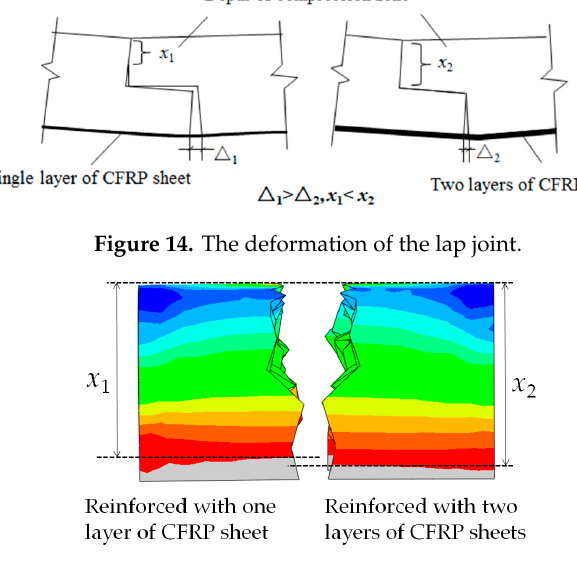
Figure 15. Comparison of the depth of compression zone.